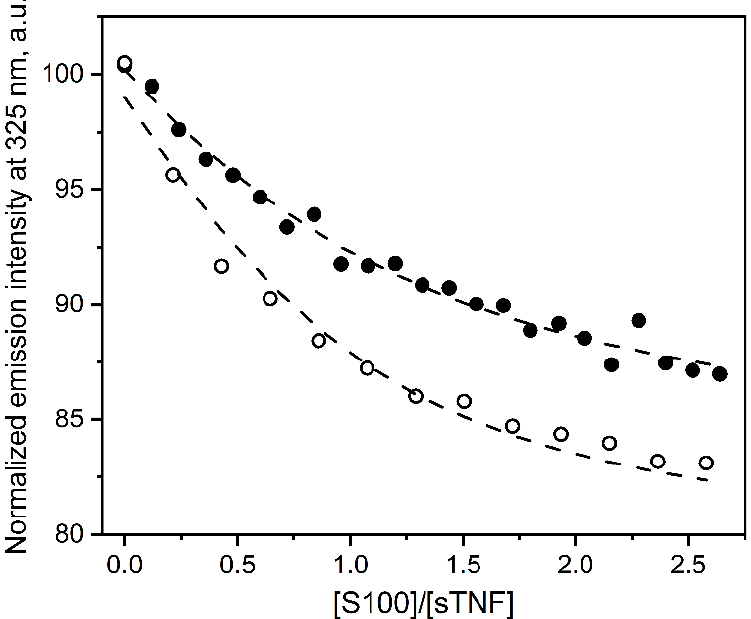
Figure 2. The interaction of sTNF with Ca 2+ -bound S100A11 (open circles) or S100A12 (solid circles) at 25 °C, followed by fluorescence emission of Trp residues of sTNF (10 mM HEPES-NaOH, 150 mM NaCl, 1 mM CaCl 2 , pH 7.4). sTNF concentration of 280 nM or 0.5 µM for the titrations by S100A11 and S100A12, respectively. The excitation wavelength was 295/298 nm. The circles denote the experimental data, while the dashed curves are fits according to a single site binding model.